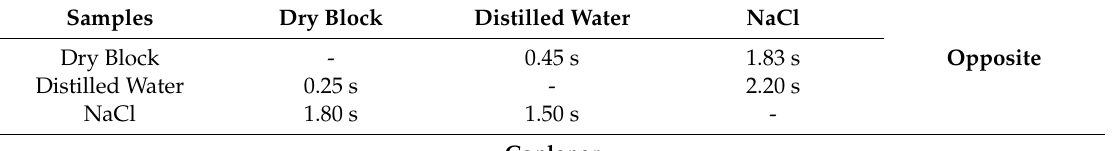
Table 3. Time di ff erence for both configurations (coplanar and